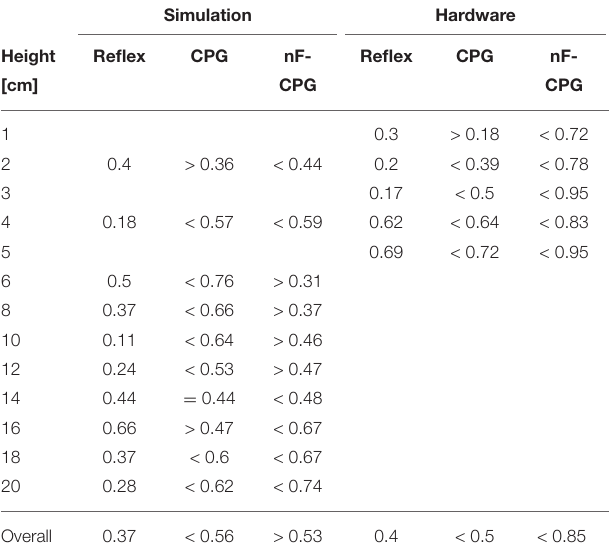
TABLE 2 | Error half-life times (in seconds) for the different fall disturbances in simulation and hardware; last line corresponds to the fit through all condition